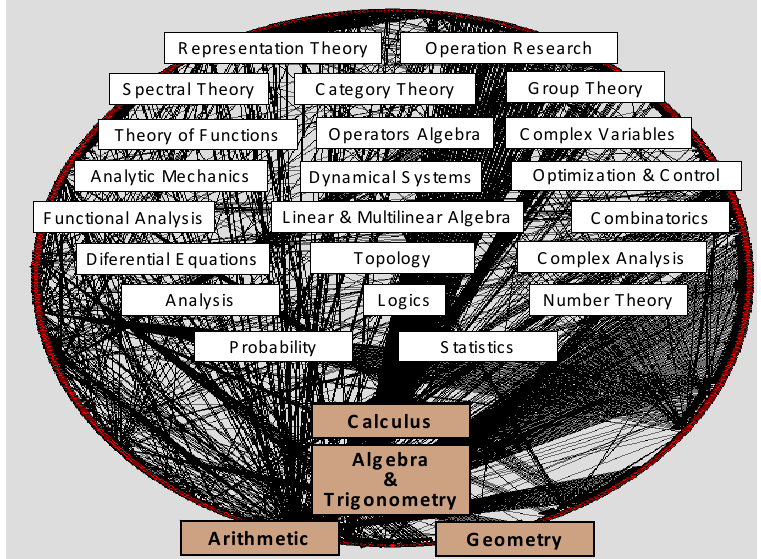
Figure 4. Subdisciplines of mathematics. Some of the main research fields and subdisciplines of contemporary mathematics are represented with an emphasis on the historical founders of modern science (algebra and calculus) and on the most ancient modules (arithmetic and